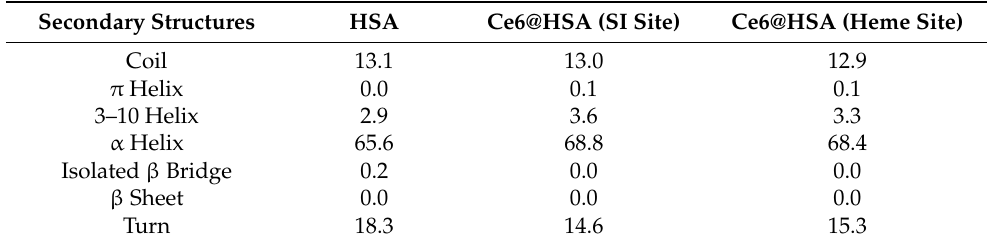
Table 1. Percentage of the secondary structure in HSA during 1 µ s MD simulations for